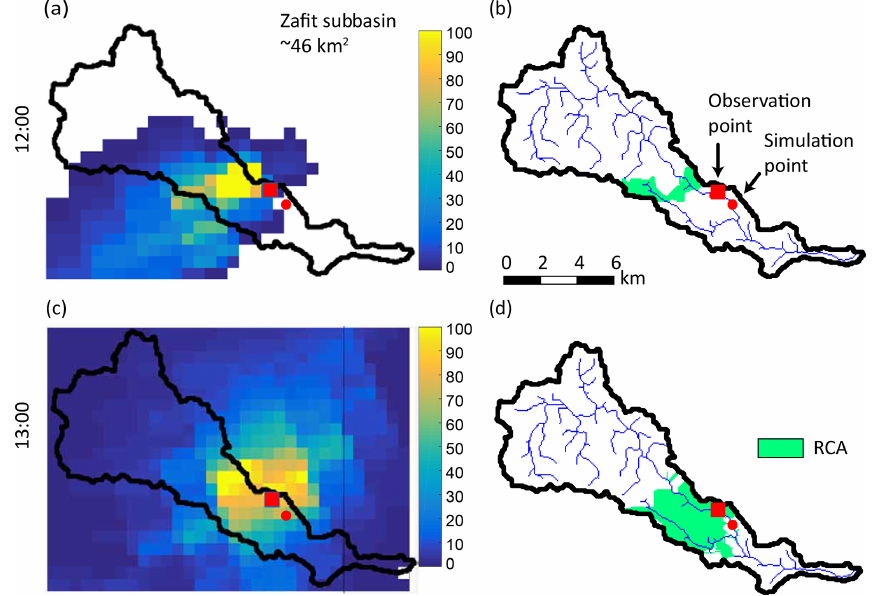
Figure 6. (a, c) 10min rainfall maps and (b, d) RCA extent for the Zafit subbasin at 12:00 and 13:00 (on 26 April). Red rectangles represent the observation points and red circles the simulation points for the spatial validation (Table 3), lag-time calculations, and Video.